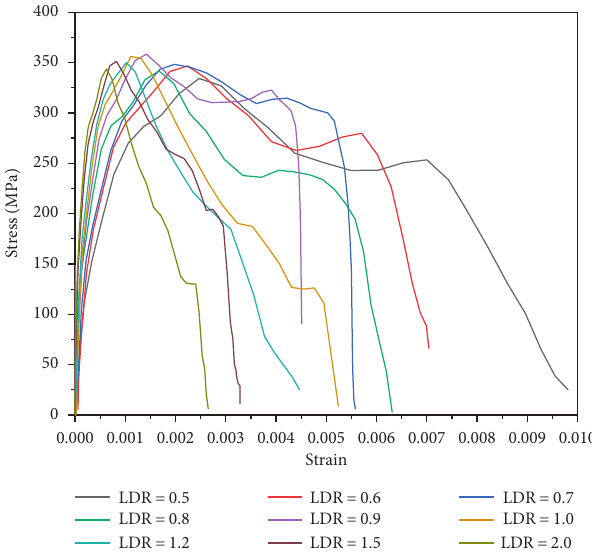
Figure 3: Stress-strain curves of